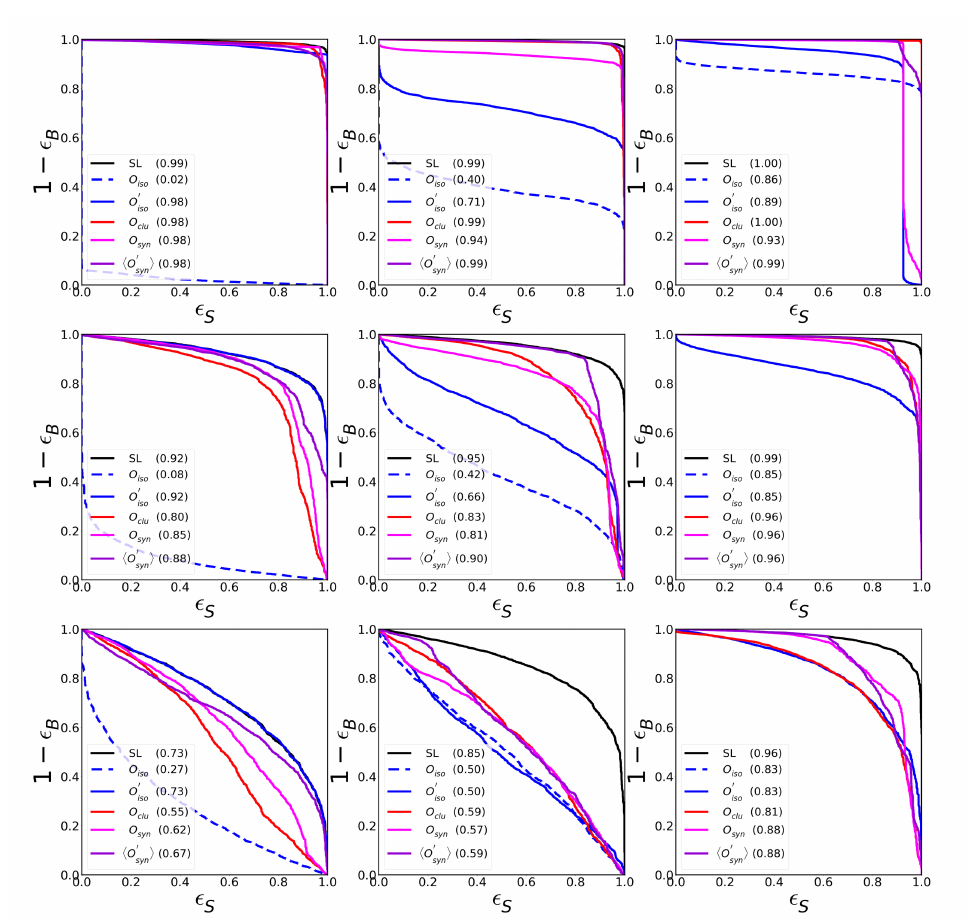
Figure 8 . ROC curves and their AUC values (given in brackets) for the set of novelty evaluators considered, applied to the 2D Gaussian testing samples corresponding to the same BPs as in figure 3. Here r = 0 . 7 is taken to define the signal-like sample S 0 for training O 0 0 performance from supervised learning (SL) has also been reported. The dashed and solid blue curves are fully overlapped in the panels of the right